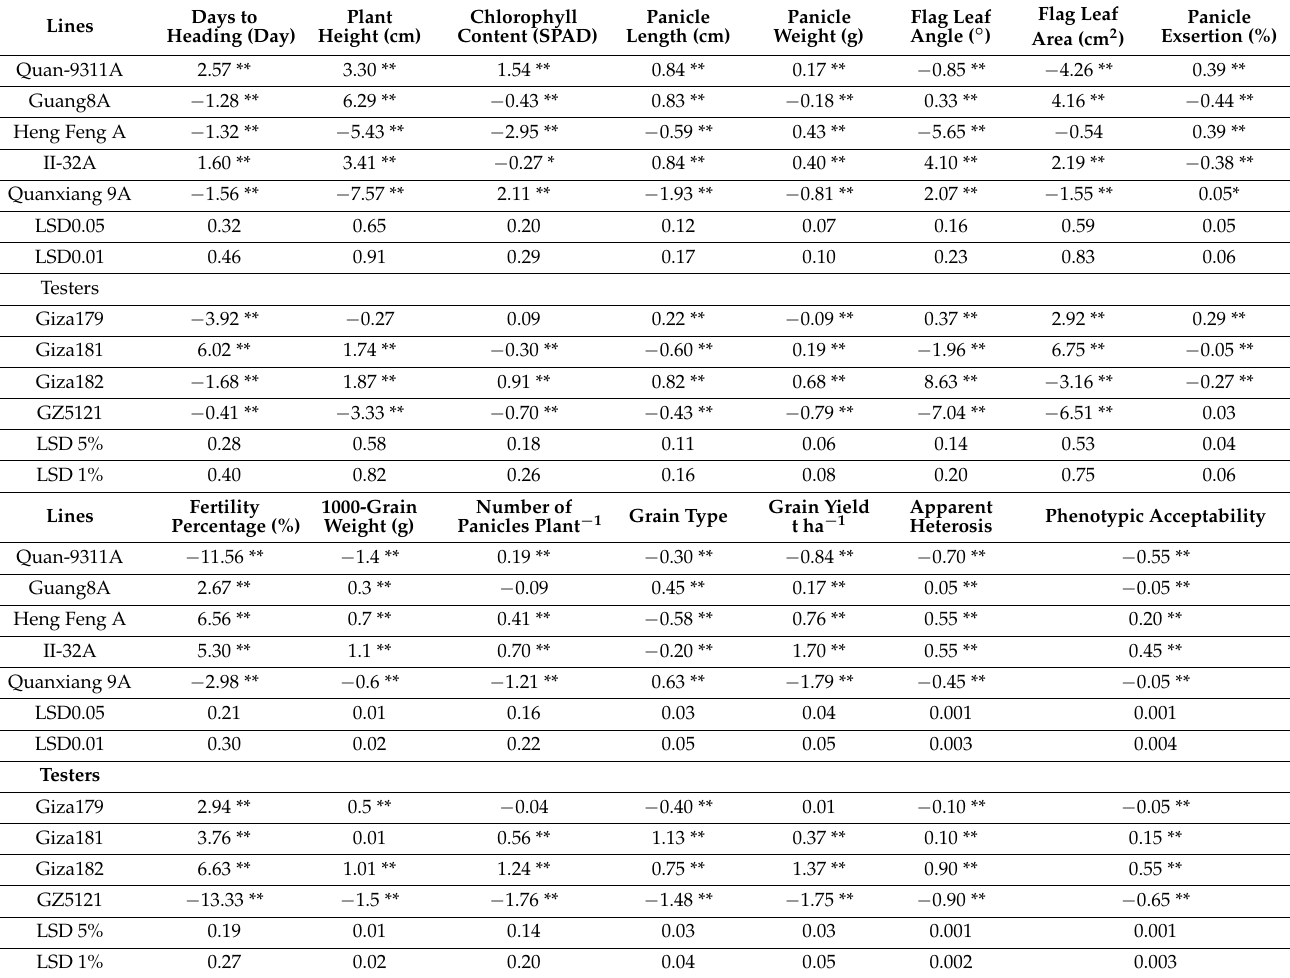
Table 3. General combining ability effects of lines and testers for studied traits.